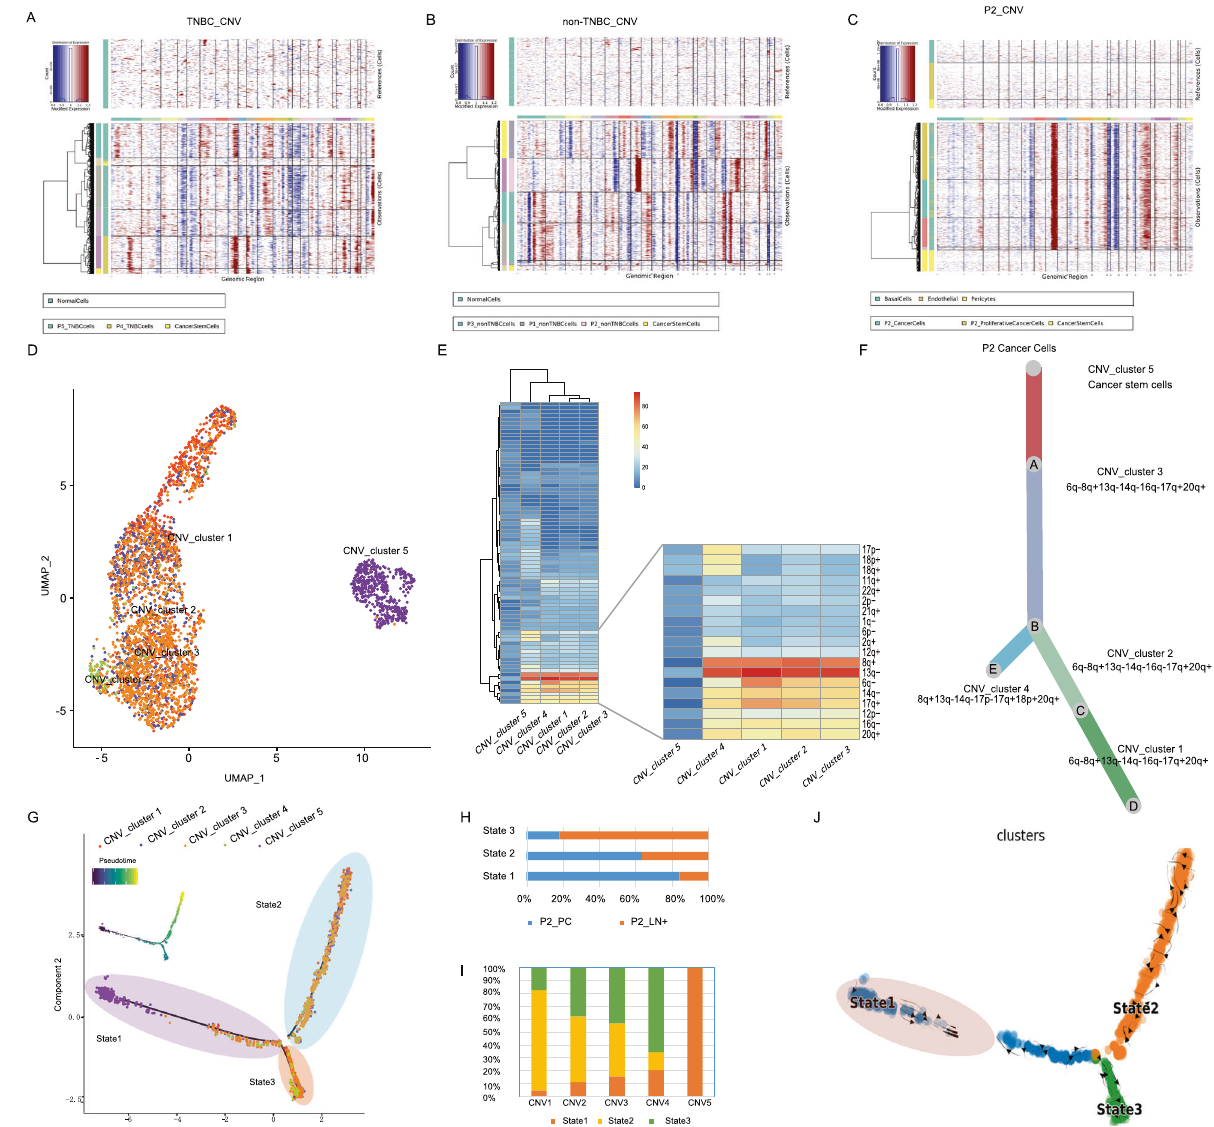
Fig. 2 Identi fi cation of breast cancer stem cells and evolutionary course of breast cancer. A , B InferCNV pro fi les of TNBC ( A ) and non-TNBC ( B ) breast cancer samples. Breast cancer stem cells were characterized with high similarity to normal tissue and presented with few mutations compared with other breast cancer cell clusters. C InferCNV pro fi les of cancer cells originated from Patient 2. D UMAP plots of cancer cells originated from Patient 2, colored according to clusters categorized by CNV characteristics. E Mutation pro fi les of CNV_clusters. F Evolutionary tree showing the developmental course of fi ve CNV_clusters. CNV_cluster 5 was among BCSC identi fi ed in previous research. G Pseudotime trajectory demonstrating the transcriptome lineage of fi ve CNV_clusters. Colors indicate pseudotime progression. Cell states are indicated with colored shadows. H , I Bar plots showing the correlation between evolutionary state and sample origin. J RNA-velocity demonstrating the differentiation direction of breast cancer